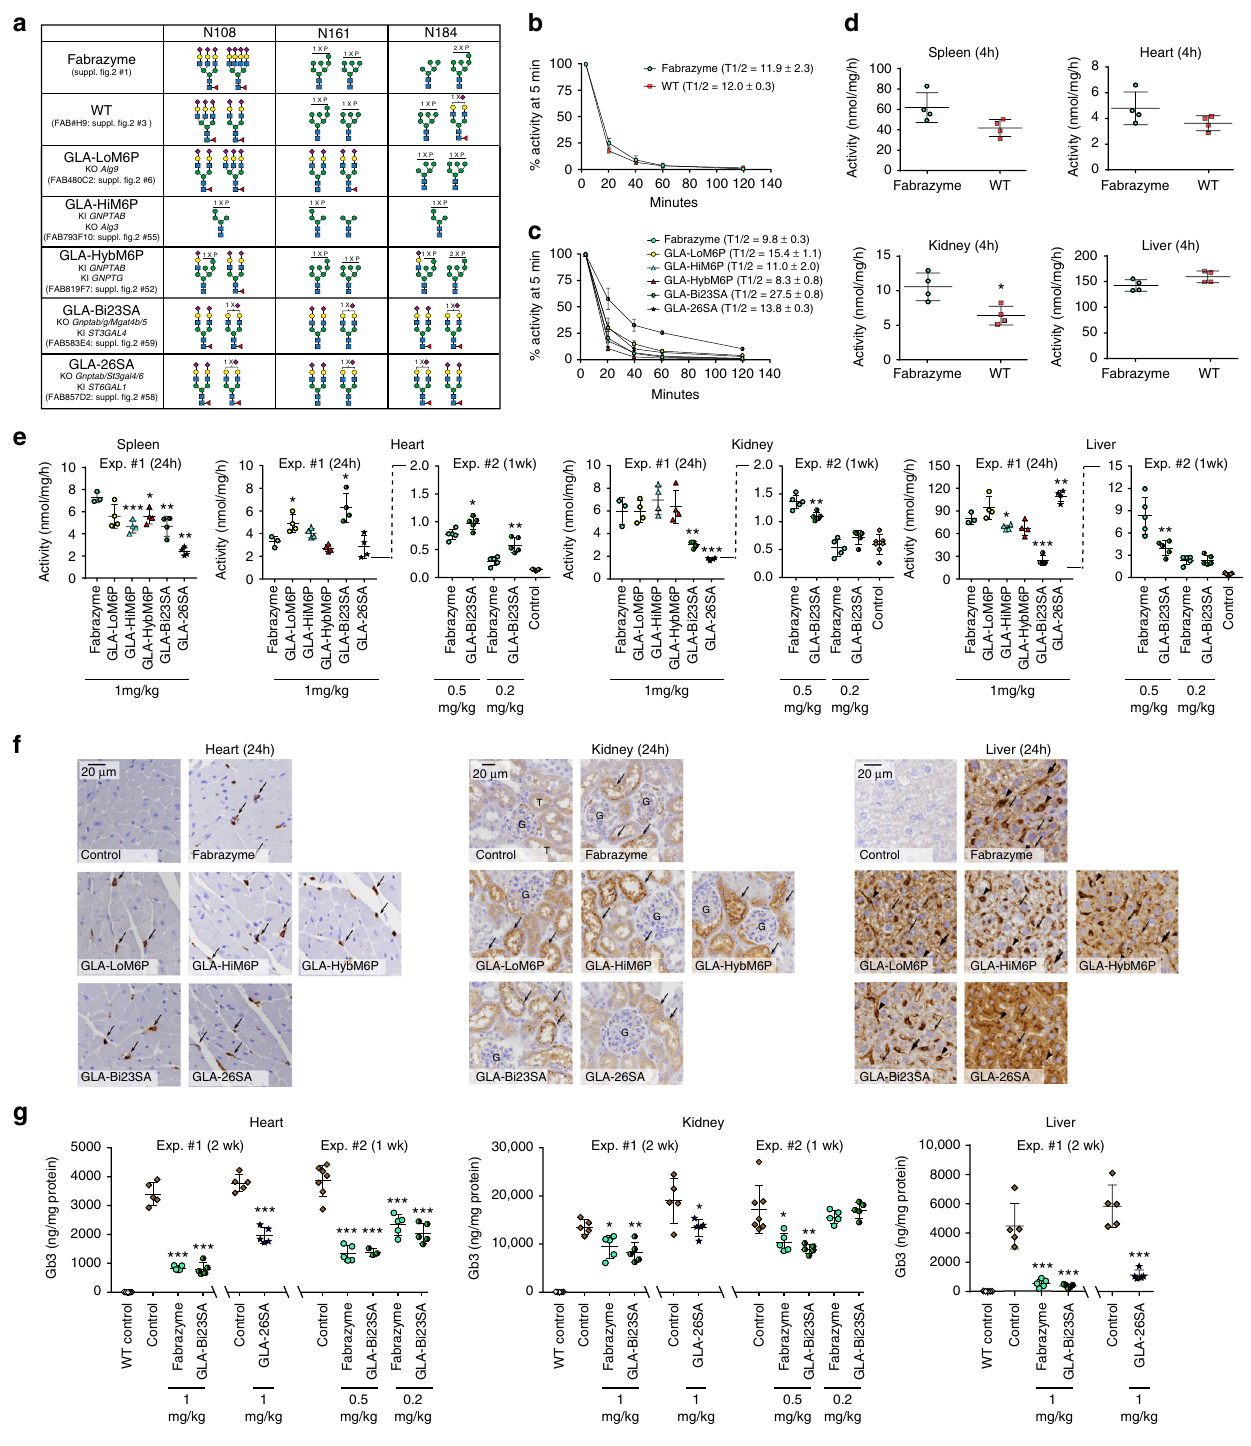
Fabrazyme (suppl. fig.2 #1) WT (FAB#H9: suppl. fig.2 #3 ) GLA-LoM6P KO Alg9 (FAB480C2: suppl. fig.2 #6) GLA-HiM6P KI GNPTAB KO Alg3 (FAB793F10: suppl. fig.2 #55) GLA-HybM6P KI GNPTAB KI GNPTG (FAB819F7: suppl. fig.2 #52) GLA-Bi23SA KO Gnptab/g/Mgat4b/5 KI ST3GAL4 (FAB583E4: suppl. fig.2